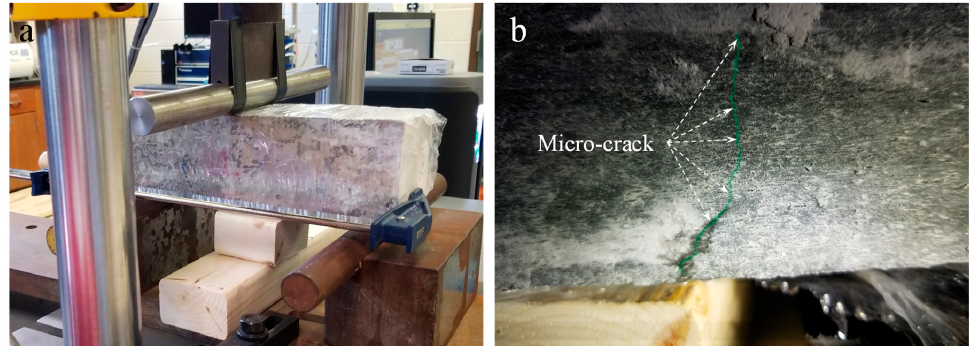
Figure 4. Self-healing test setup: ( a ) three-point loading; and ( b ) flexural crack formation.